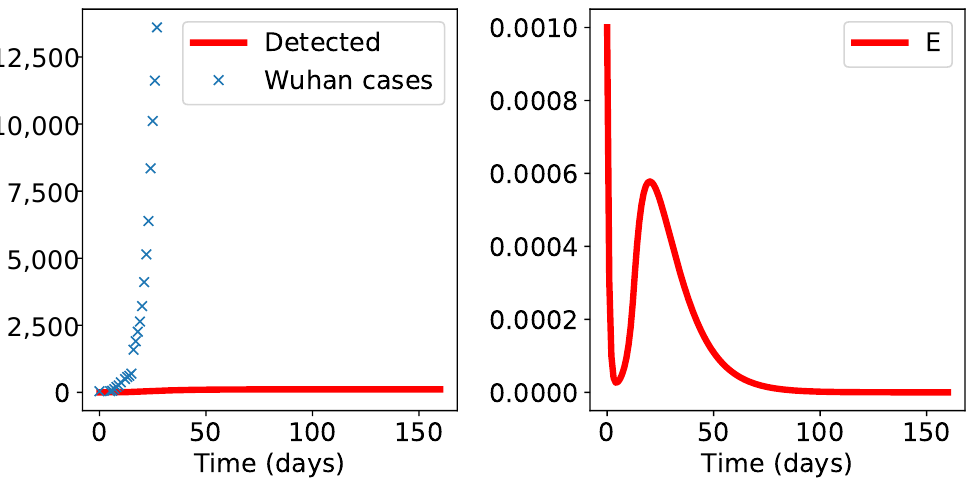
Figure 3. Results of the simulations when the environmental propagation route E-S is switched off. The classical propagation route alone induces a much smaller epidemic size than the actual data indicate.